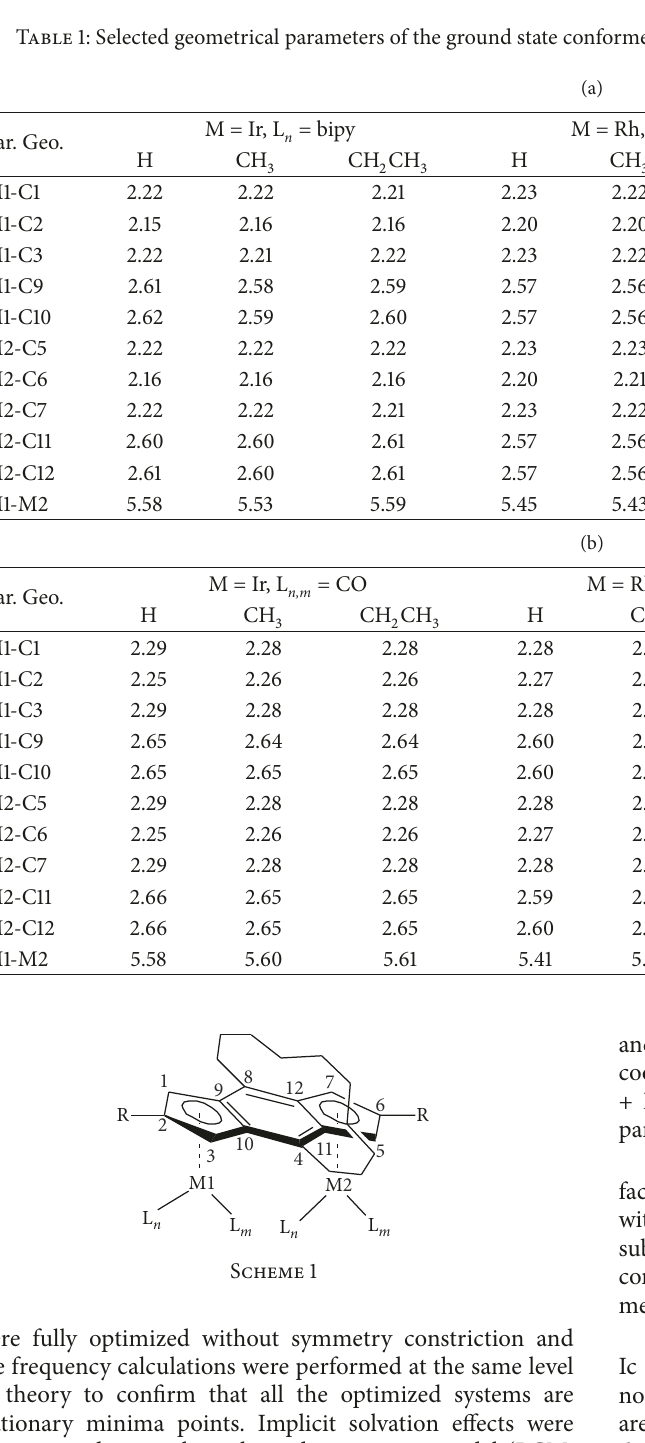
Table 1: Selected geometrical parameters of the ground state conformers. Bond lengths are given in Angstrom (˚A) (see Scheme 1). Par. Geo.